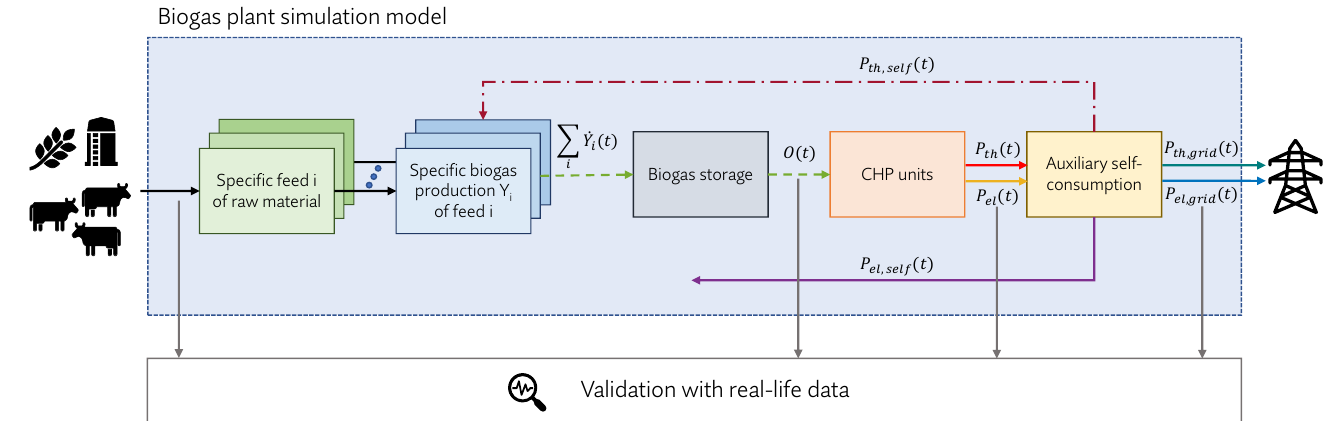
Figure 5. Block diagram of the simulation model.